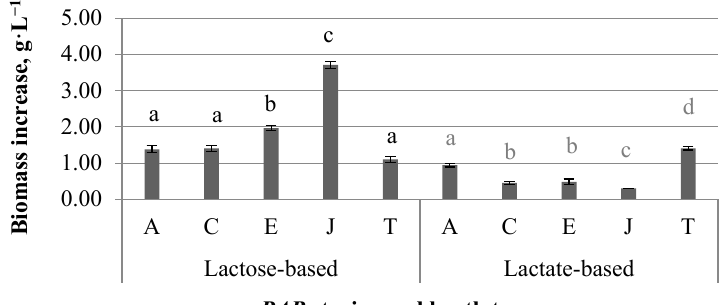
Figure 1. Biomass produced by different PAB strains in broths with added lactose or lactate as carbon sources, data are averaged from at least three independent, parallel 210 h-long cultivations; error bars represent the standard deviation of biomass increase of at least three independent fermentations ( n = 3); a, b, c, d—different small letters on bars show that biomass produced by PAB strains grown on the same substrate are different ( p < 0.05).